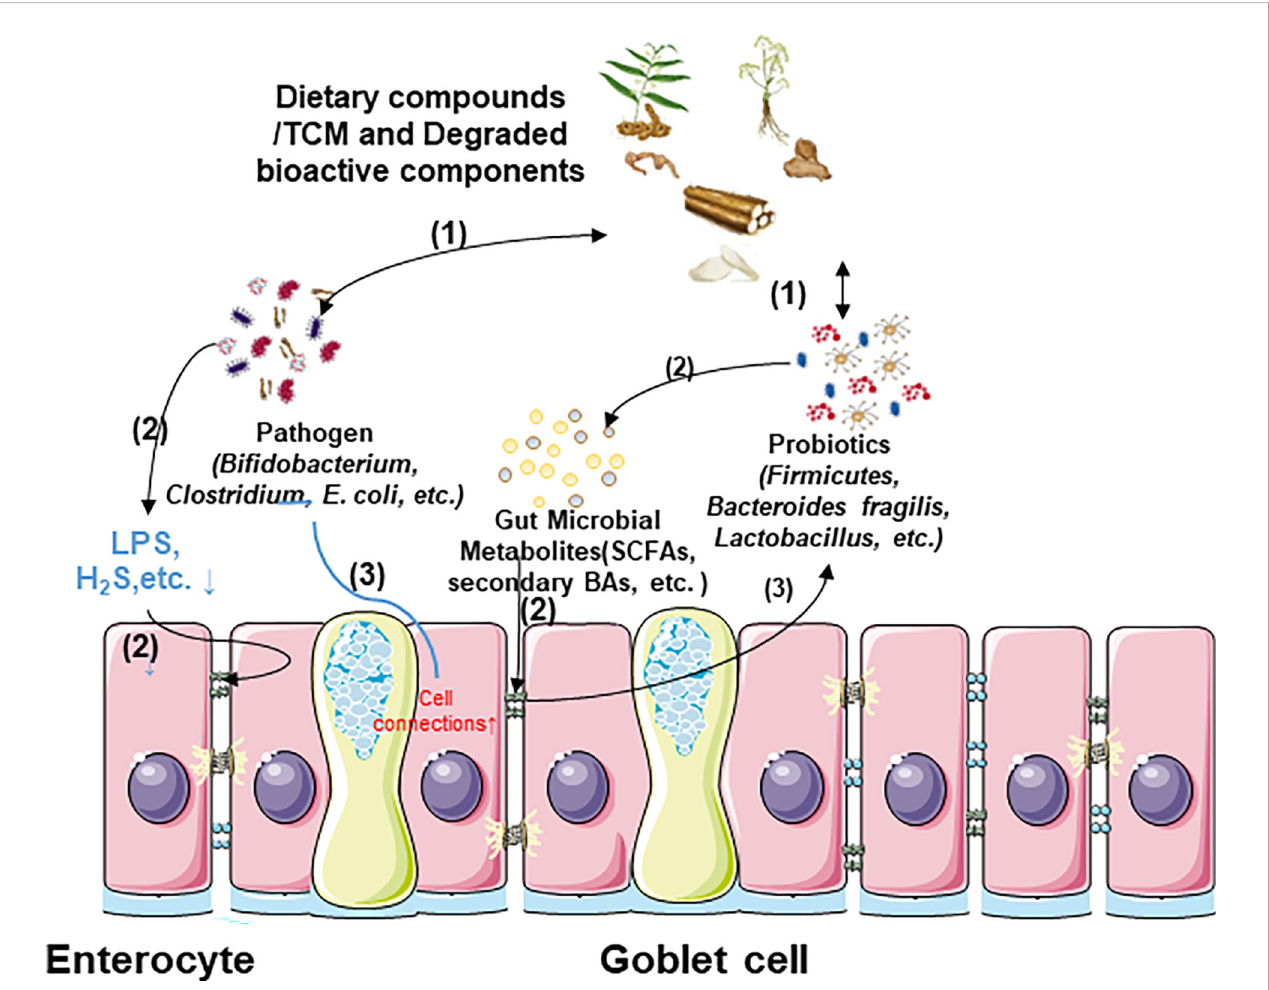
FIGURE 3 Relationship between dietary compounds/TCM and gut microbiota. (1) Dietary compounds/TCM and degraded bioactive components can modulate the micro fl ora structure, and the different composition of gut fl ora among species also in fl uences their curative effect. (2) Some gut microbial metabolites produced by probiotics restore intestinal epithelial cell barrier, and the reduction of harmful metabolites produced by pathogens also decreases intestinal barrier damage. (3) Cell barrier restoration is also conducive to gut fl ora